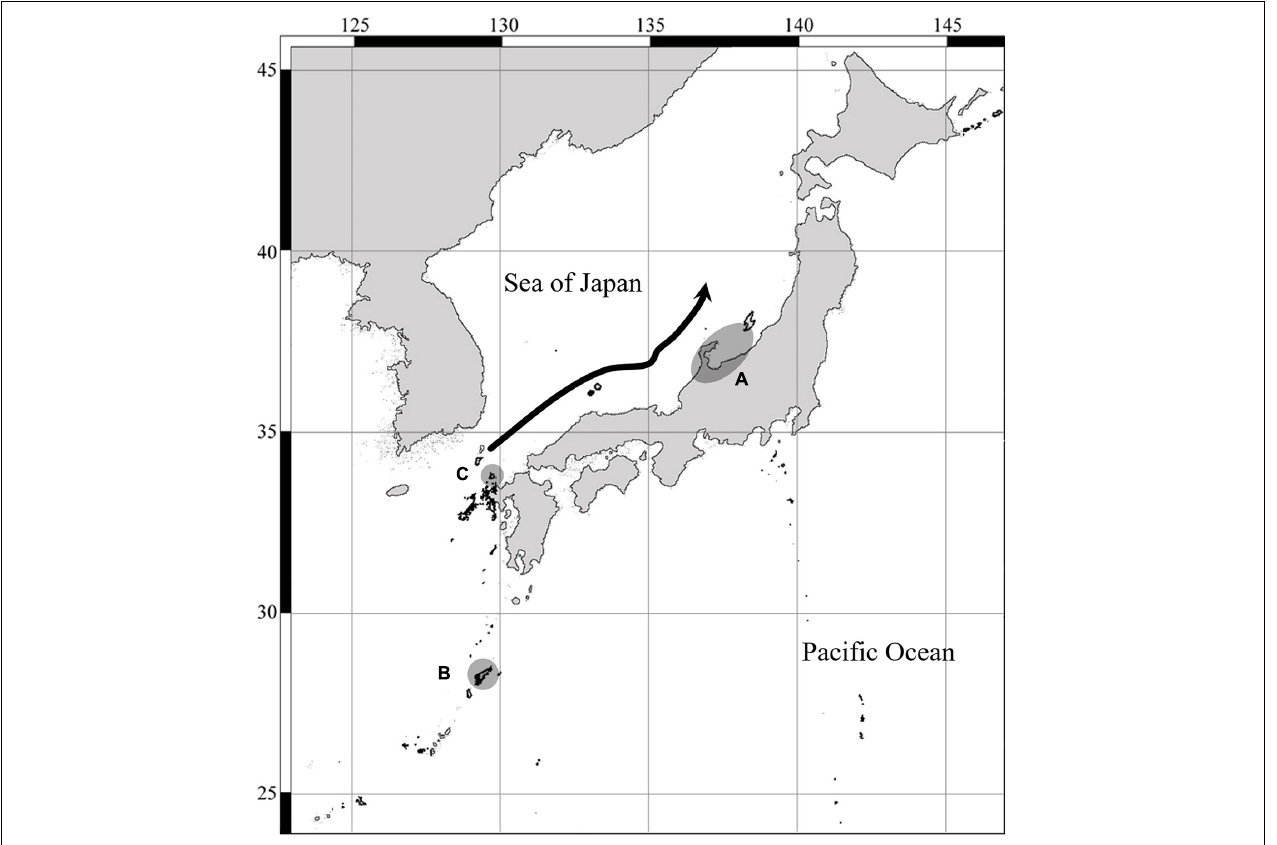
FIGURE 2 | Map of the Japanese Archipelago with indication of the regional currents. (A) Echigo region (location of capture for Takagi and Mouri’s hawksbill turtle). (B) Amami Oshima Island, northernmost nesting record of hawksbill turtle. (C) The northernmost coral reefs in Japan. Arrow indicates the Tsushima